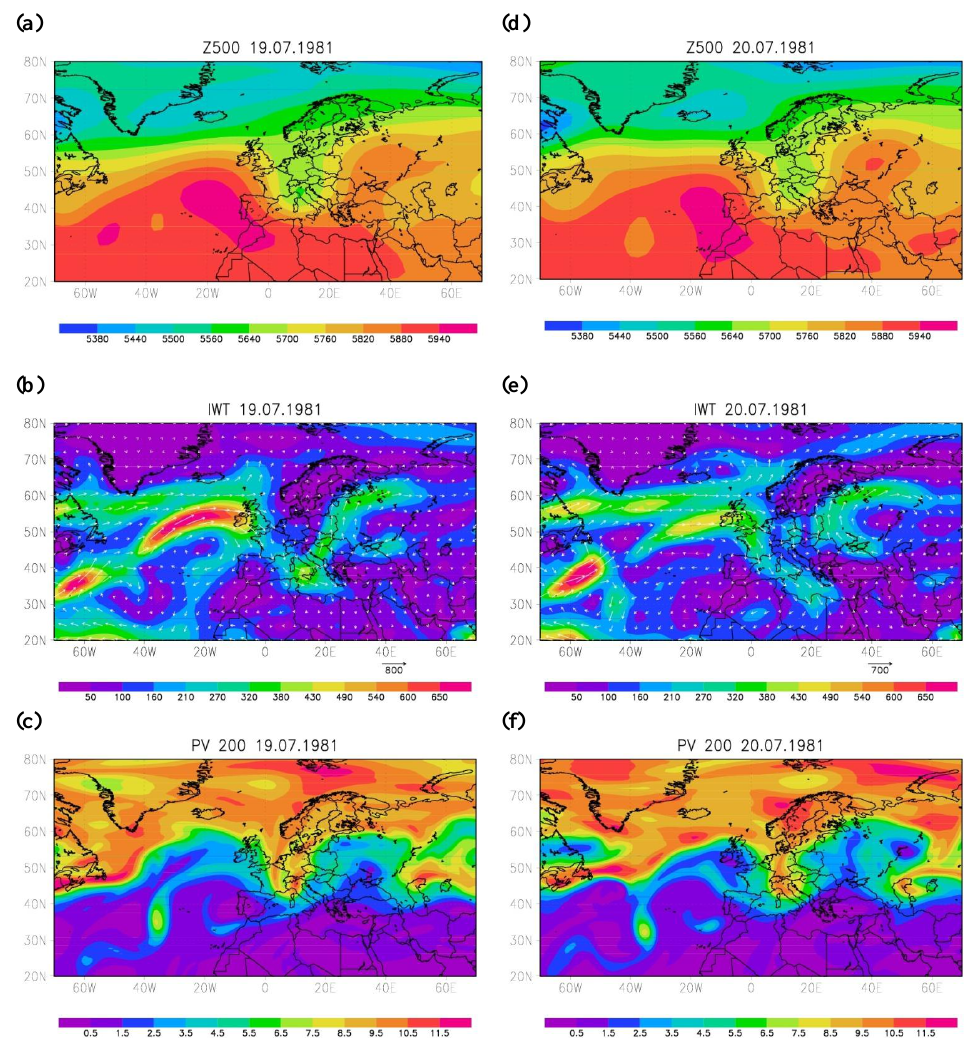
Figure 4. Synoptic-scale meteorology during the River Ammer flood days 19 and 20 June 1981: (a) Z500, (b) IWT and (c) PV for 19 June 1981; (d, e, f) as in (a, b, c) but for 20 June 1981. Units: Z500 (m), IWT (kgm − 1 s − 1 ) and PV